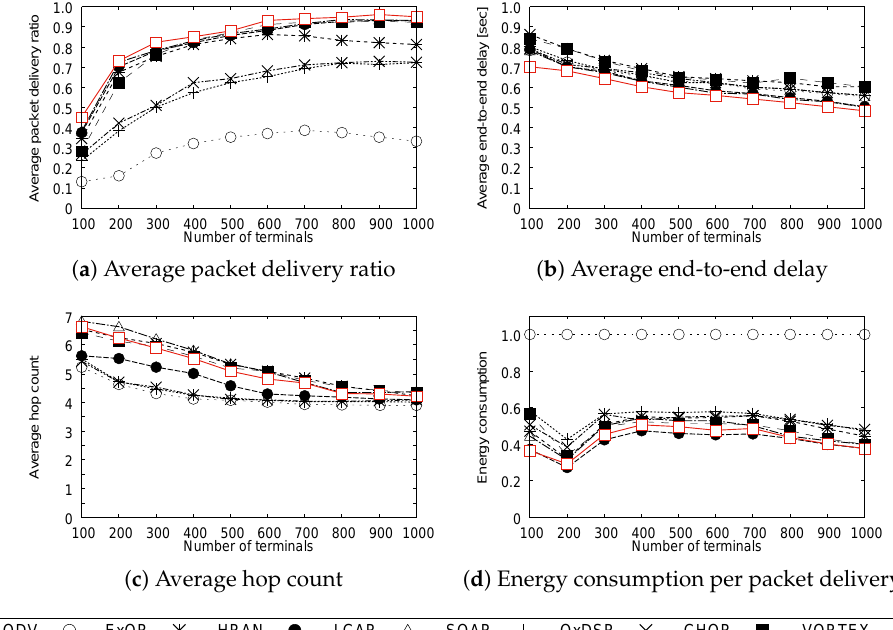
Figure 3. Results of Simulation